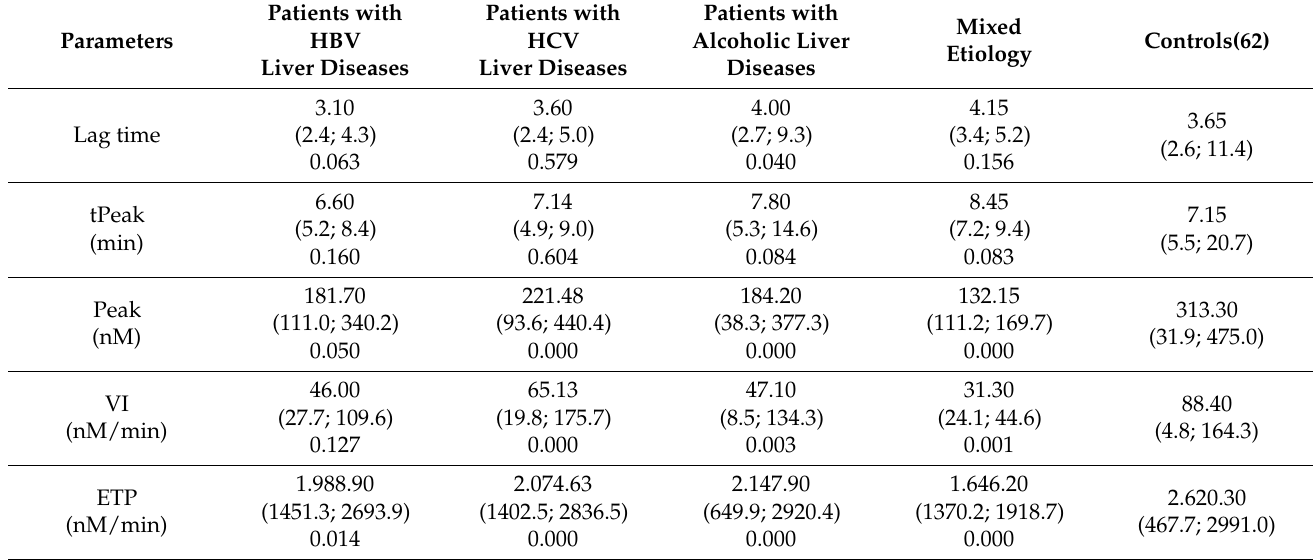
Table 4. The mean values of thrombin generation parameters according to the etiology of chronic liver diseases.